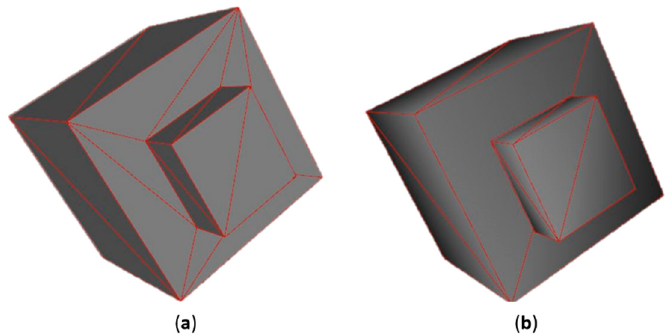
Figure 2. ( a ) Solid geometry in FME and ( b ) polyhedral surface inserted into PostGIS.